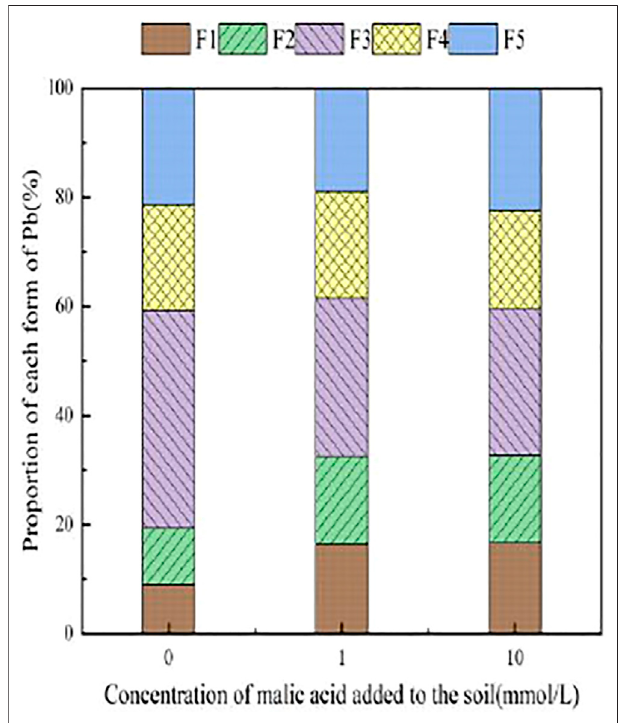
FIGURE 8 | Distribution of Pb form in